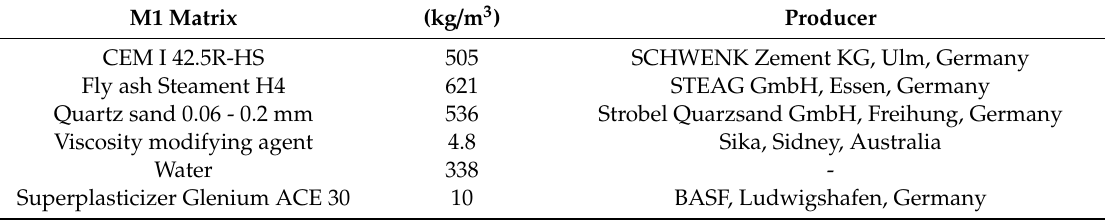
Composition of the strain hardening cement-based composites (SHCC) matrix M1 under investigation.